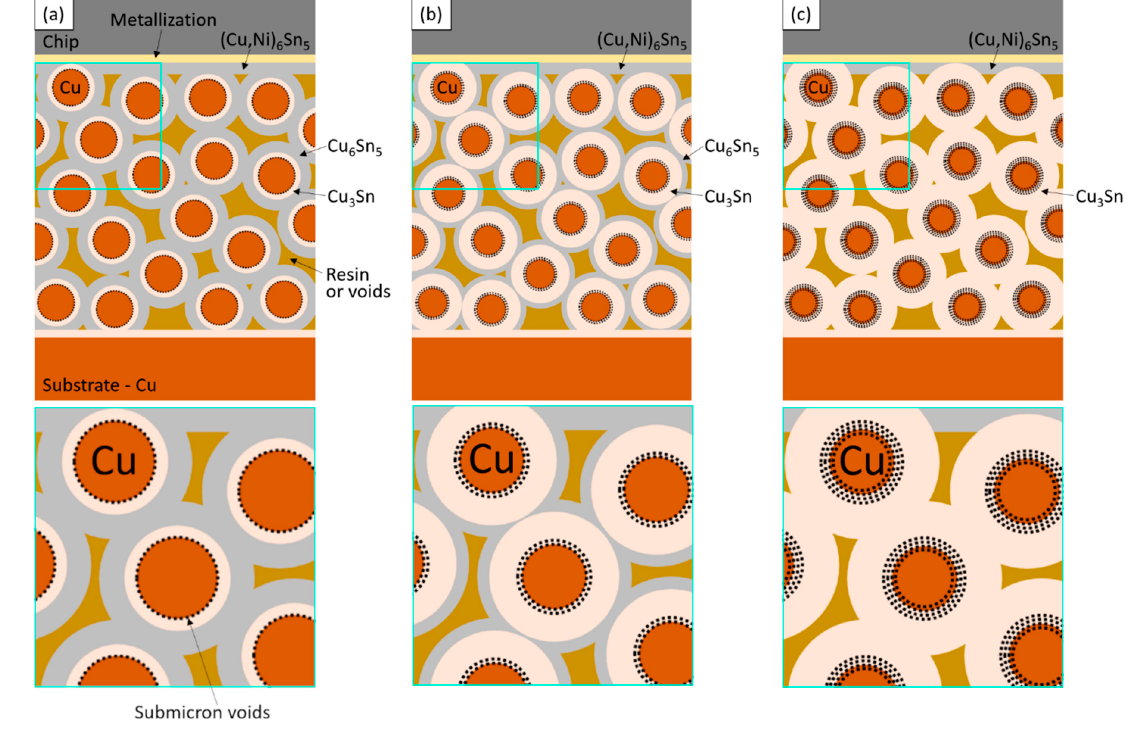
Figure 13. Mechanism model of the microstructural evolution for the TLPS layer aged at 150–200 °C: ( a ) as-bonded, ( b ) gradual transformation of Cu 6 Sn 5 into Cu 3 Sn and formation of submicron voids, and ( c ) fully-transformed structure with dominated Cu 3 Sn.